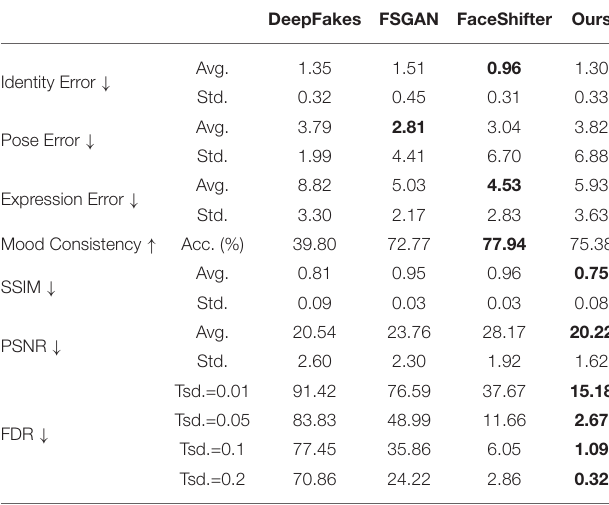
TABLE 2 | Quantitative assessment with DeepFakes (Rössler et al., 2019), FSGAN (Nirkin et al., 2019), and FaceShifter (Li et al., 2019). DeepFakes FSGAN FaceShifter